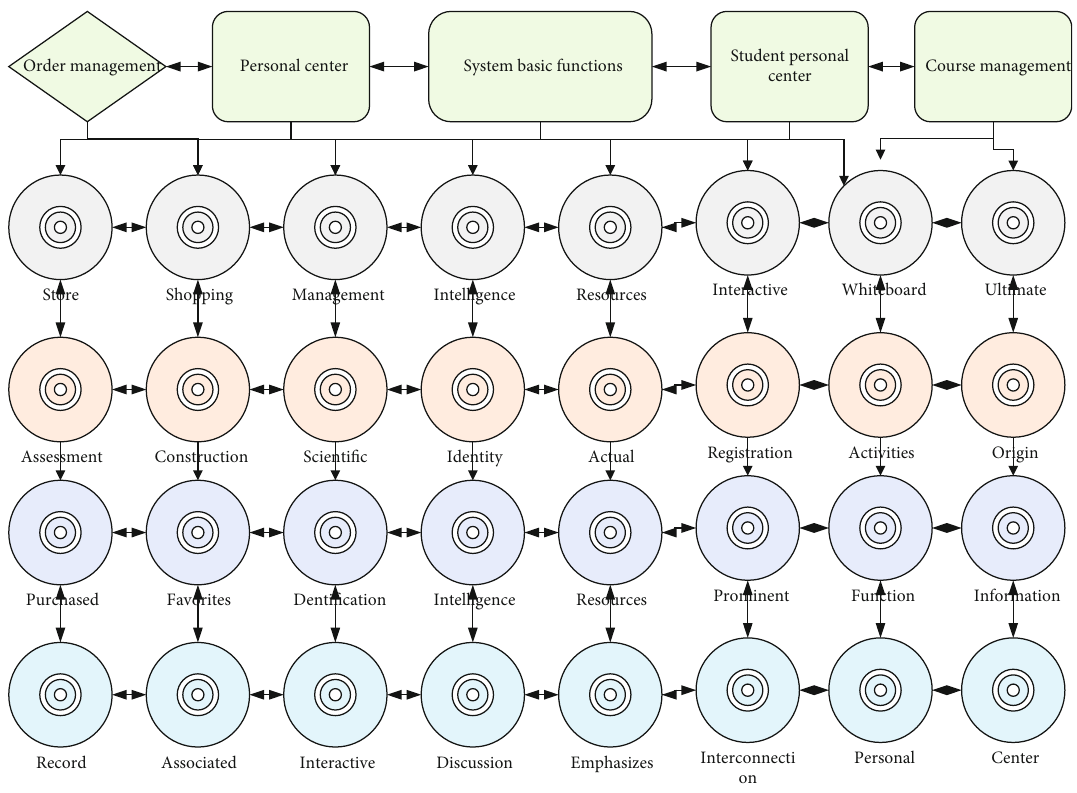
Figure 3: System use case role